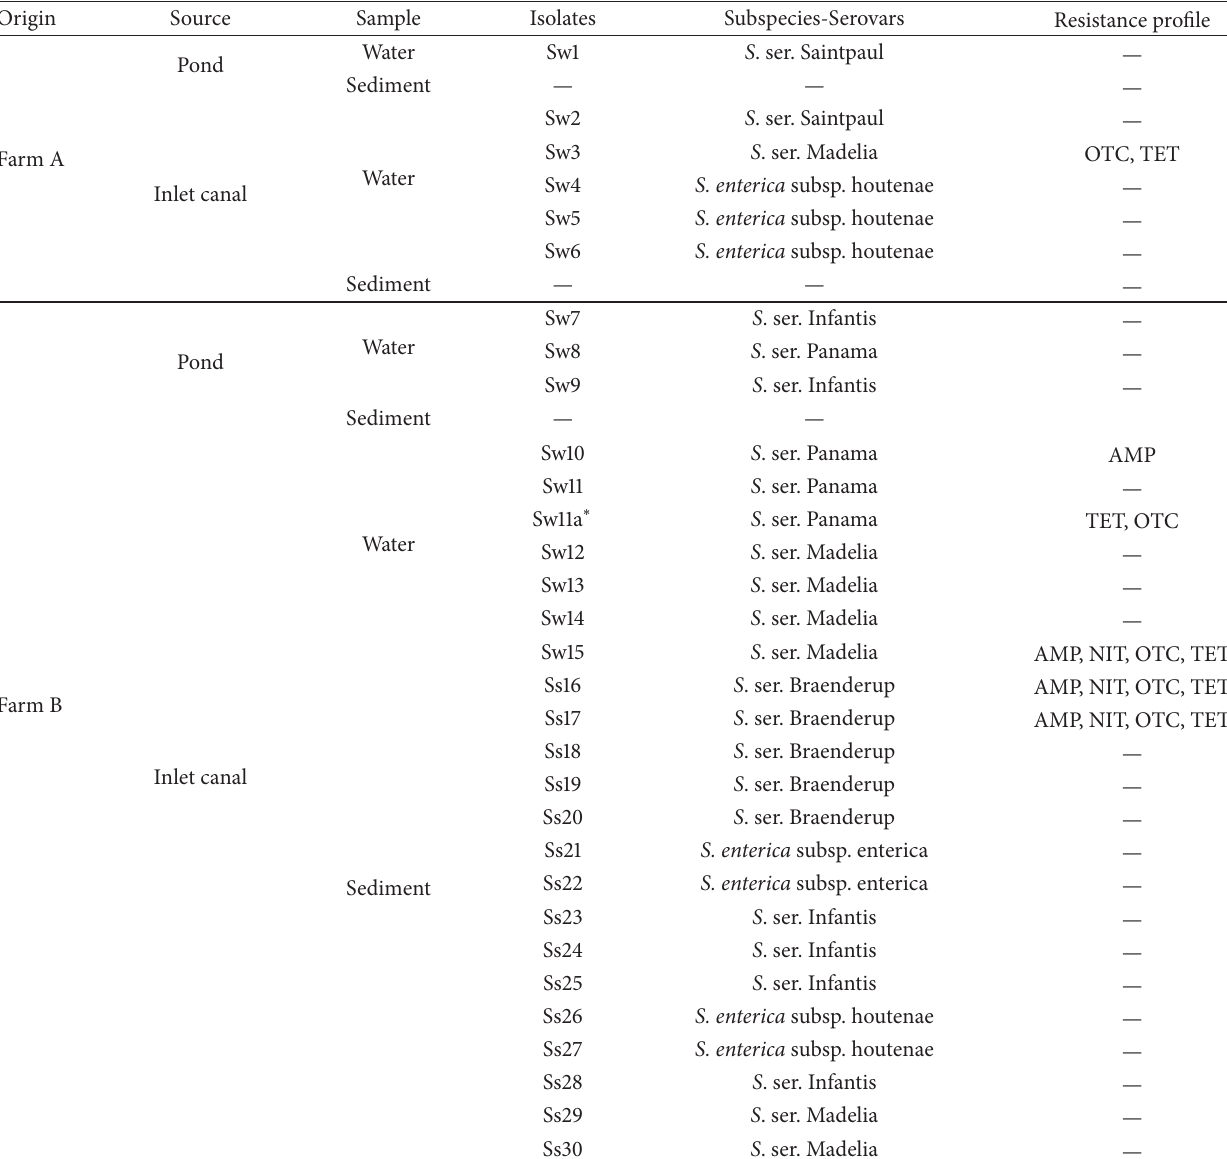
Table 1: Antimicrobial resistance profile of subspecies and serovars of Salmonella enterica isolated from water and sediment samples from ponds and inlet canal (Jaguaribe River) of two freshwater-acclimated Litopenaeus vannamei culture farms (A and B), Ceara,